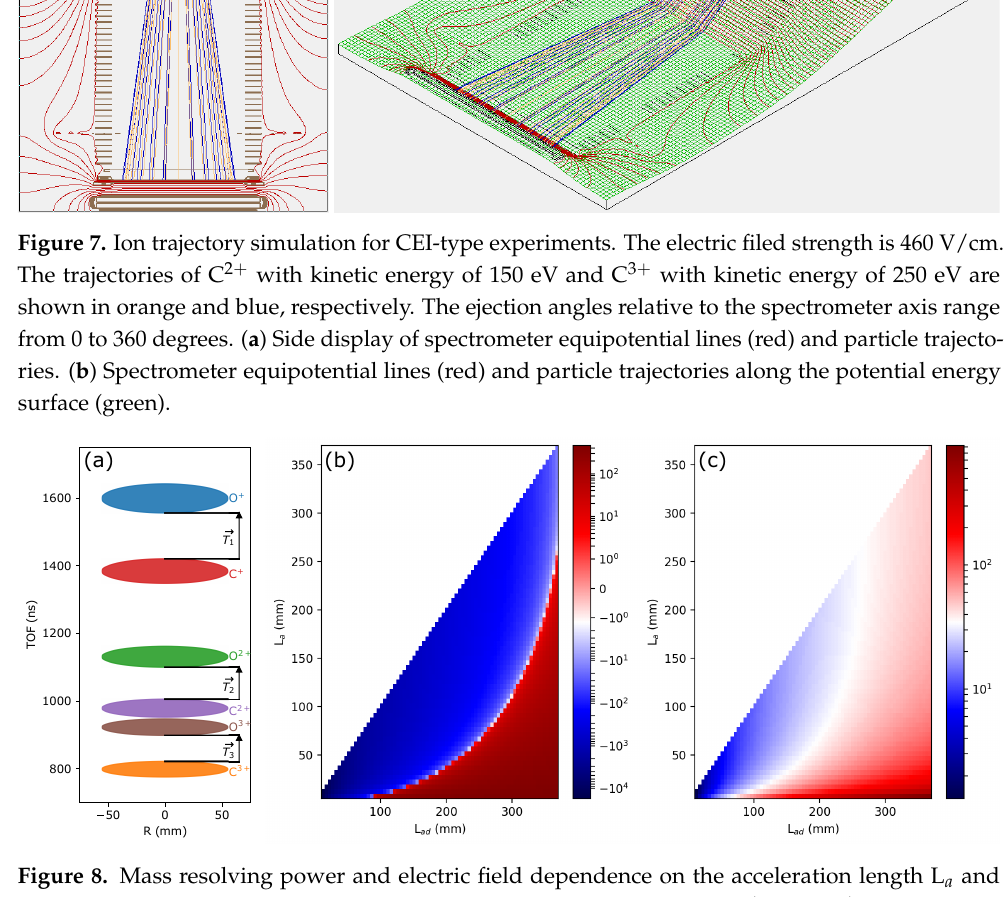
−→ T i connects the point of −→ T i is used as the metric for the mass i = 1 −→ T i (ns) on the acceleration i = 1